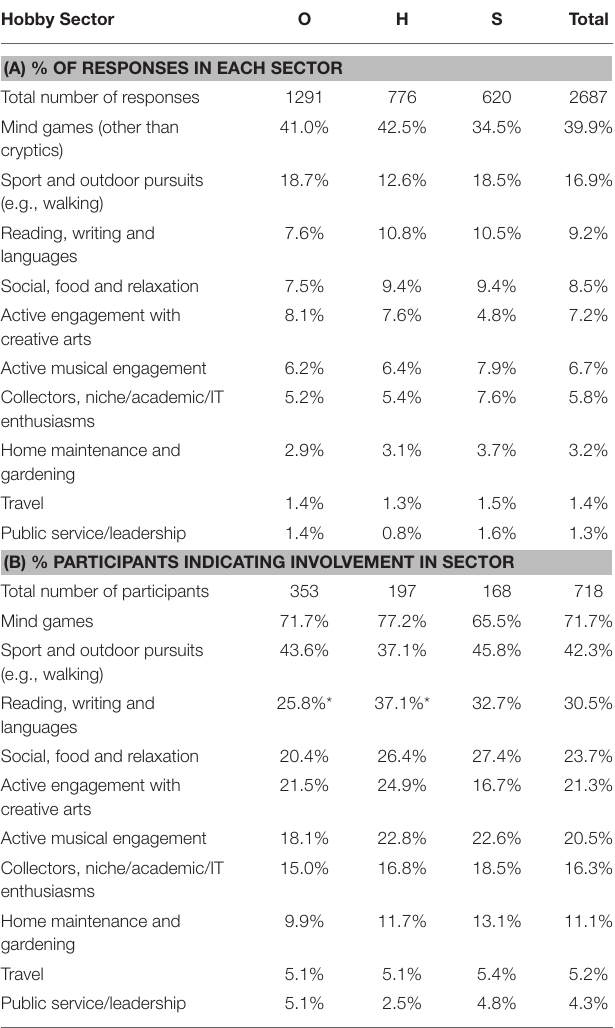
TABLE 8 | Hobby sectors by expertise, showing % of total responses and % of participants with at least one interest in the sector. Hobby